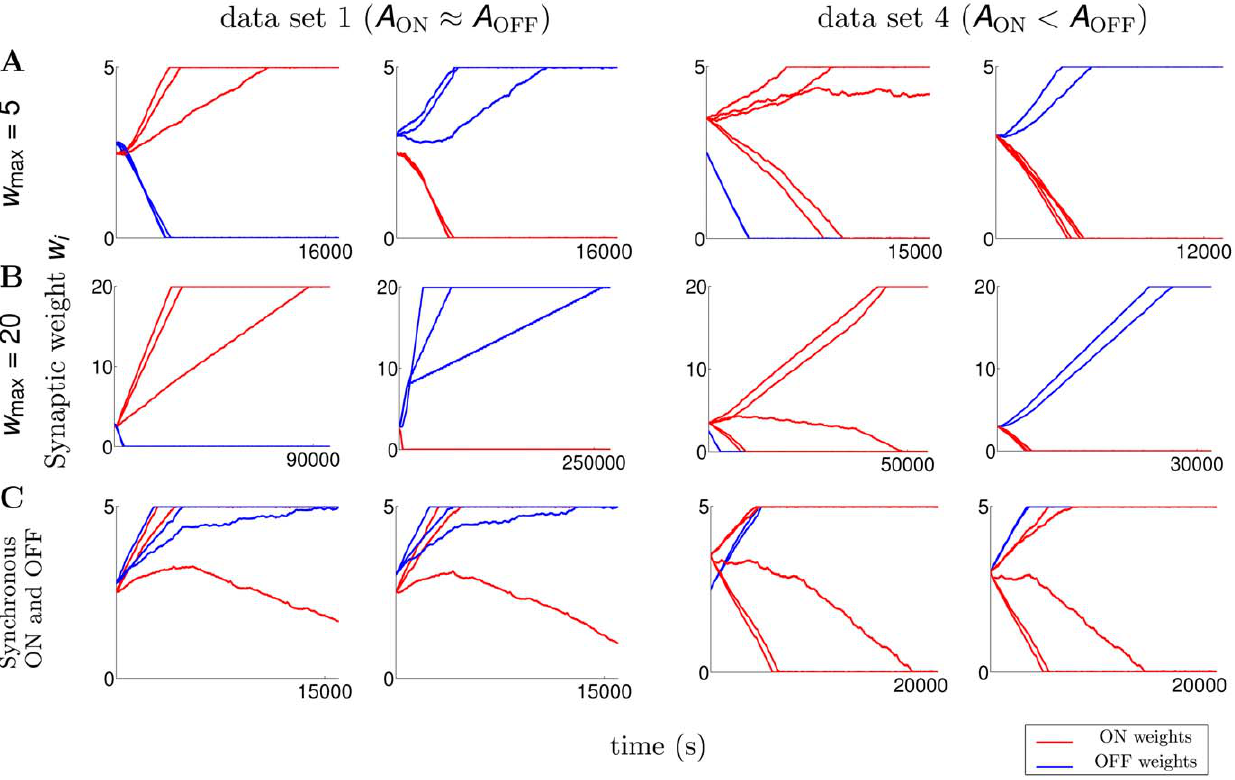
Figure 6. Features which guide segregation under BTDP. (A) Temporal evolution of synaptic weights with R ~ I = A z ~ 0 : 30 for data set 1 (3 ON and 3 OFF cells), as in Figure 4A, for initial conditions when the ON (first column) or the OFF cells (second column) segregate. Similarly, sample trajectories for data set 4 (5 ON and 2 OFF cells), as in Figure 4B, for initial conditions where the ON (third column) or the OFF cells (fourth column) segregate. Upper bound on the weights w max ~ 5 . Even though there are more ON than OFF inputs in data set 4, the outcome does not depend on the number of ON and OFF inputs, but on the initial conditions of the synaptic weights. Furthermore, a simple bias in the initial conditions does not always result in segregation towards the biased cell (see Figure 4 for the segregation outcome for all initial condition combinations). (B) Increasing the upper bound of the weights to w max ~ 20 does not affect the segregation outcome; weights simply take longer to segregate. (C) Delaying the time of the spikes of ON cells by 1 second, such that they are synchronous with OFF cells, eliminates